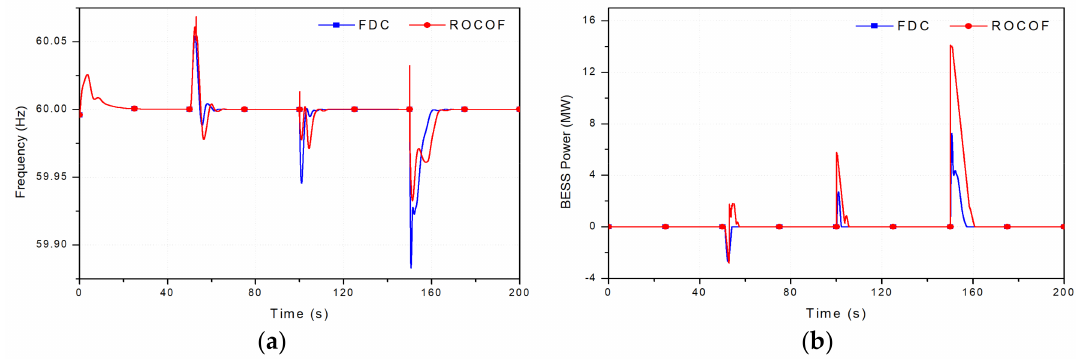
Figure 23. BESS effects when the load is increased (0~200 s): ( a ) Frequency; ( b ) BESS